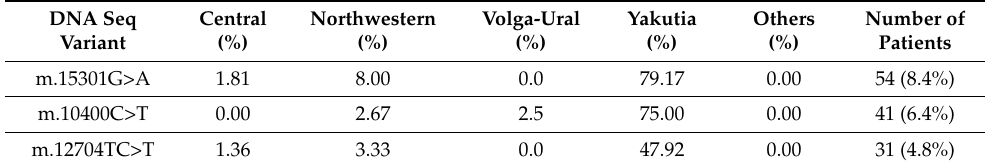
Table 5. Top-3 non-ancestral variants that are frequent in Yakutia and rare in other regions. Columns from left to right: mtDNA sequence variant, the frequency of the variant in each region (% from the number of samples in each region), the total number of patients carrying the variant. DNA Seq Central Northwestern Volga-Ural Yakutia Others Number of Variant (%) (%) (%) (%) (%) Patients